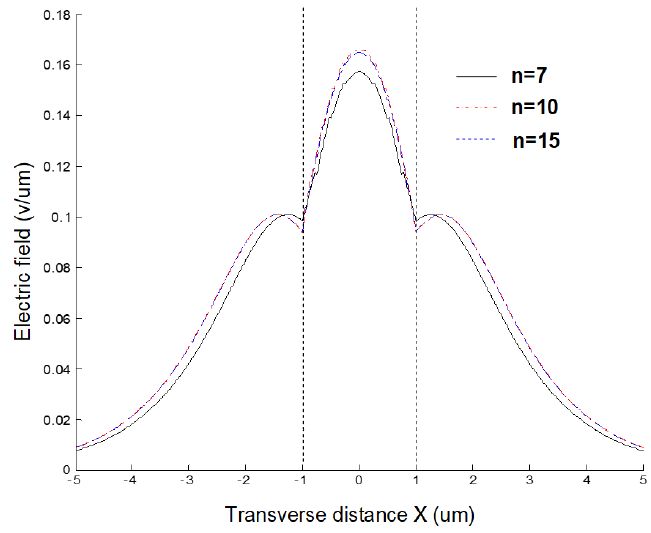
Figure 12. The electric field distribution of the multilayer metamaterial waveguide with MQW structure ( W = 2 µm ).